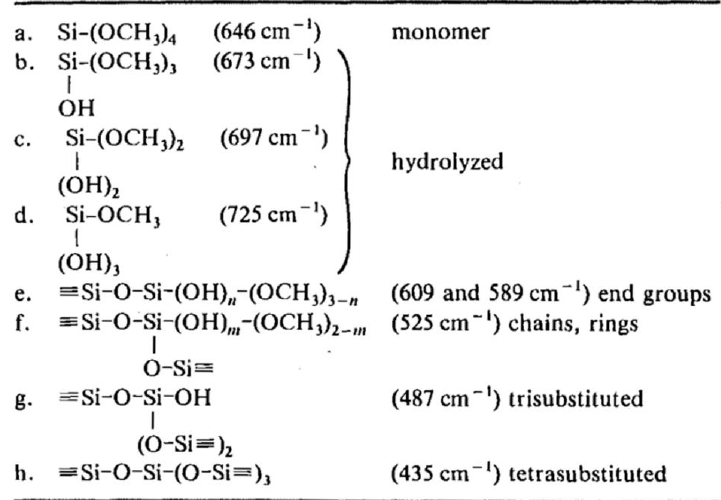
Table 7. The Raman peaks of the TMOS species. Reprinted with permission from [4]. Copyright Elsevier, 1990.